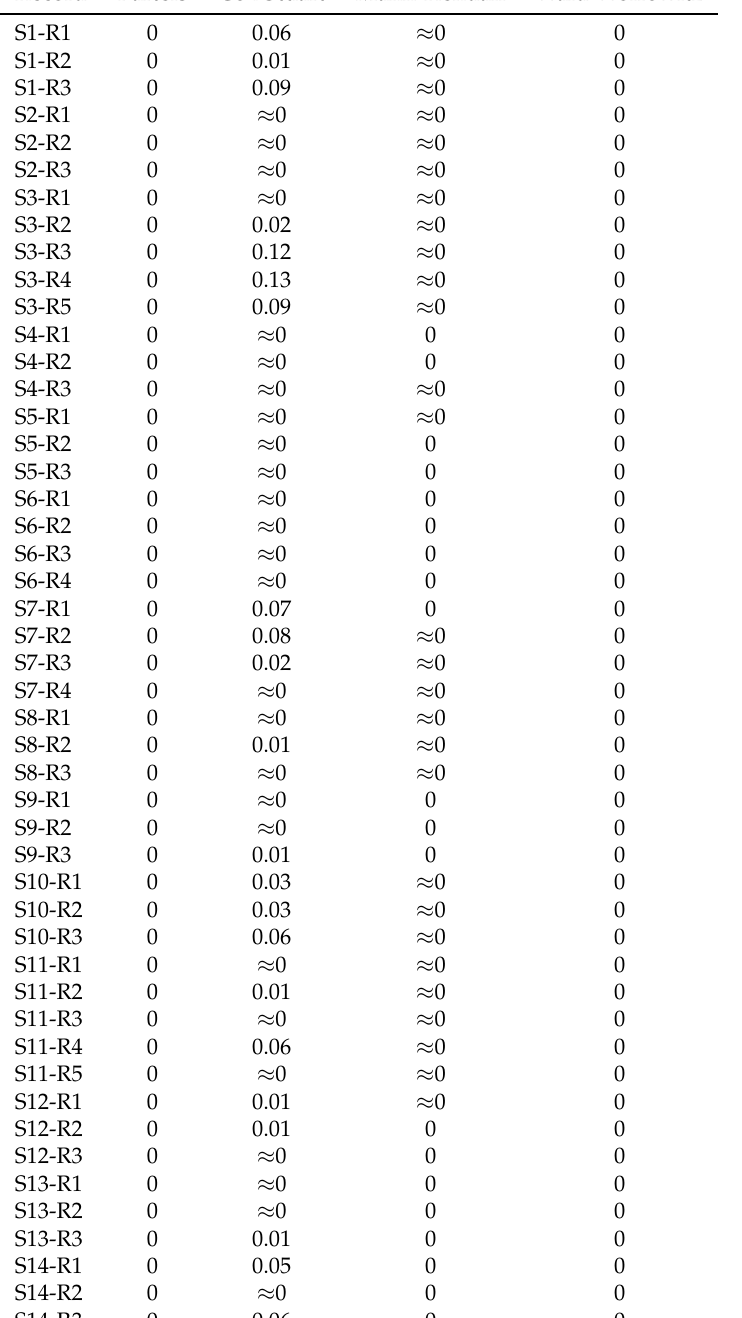
Table 2. p -values of randomness